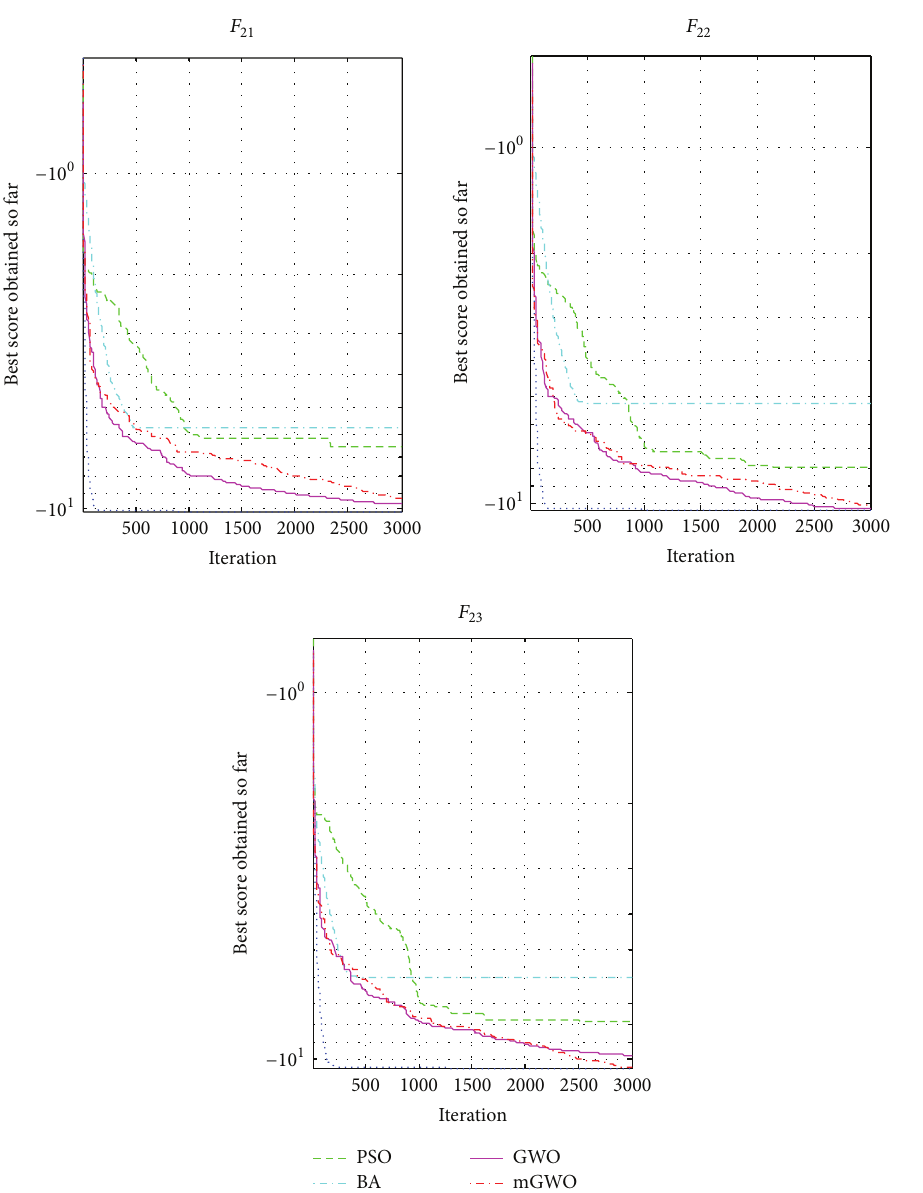
Figure 4: Convergence graph of fixed-dimension multimodal functions.